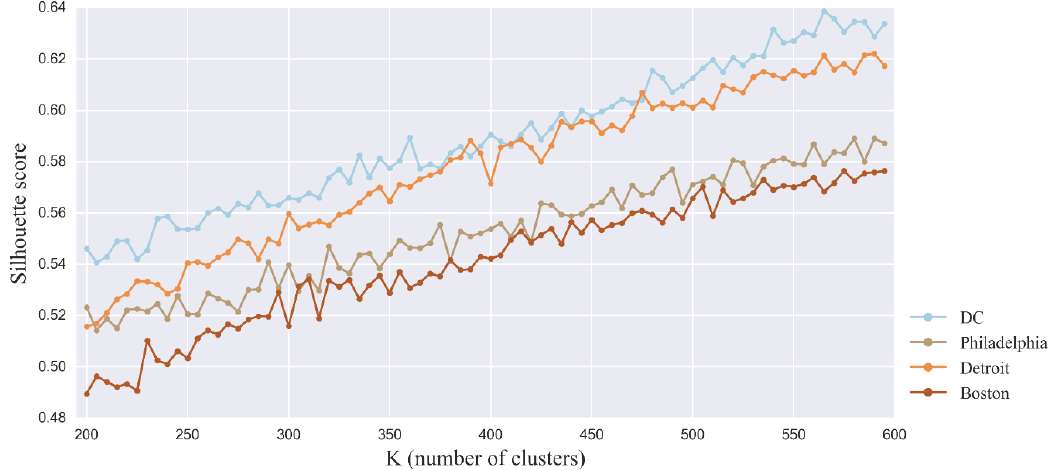
Figure 6. Silhouette scores for different Ks for different cities (small-grained spatial bins).